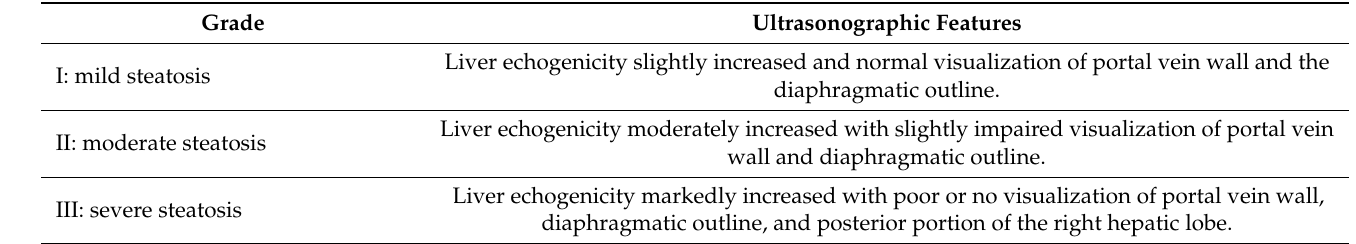
Table 1. Criteria used in the B-mode US grading of steatosis [5,27] .